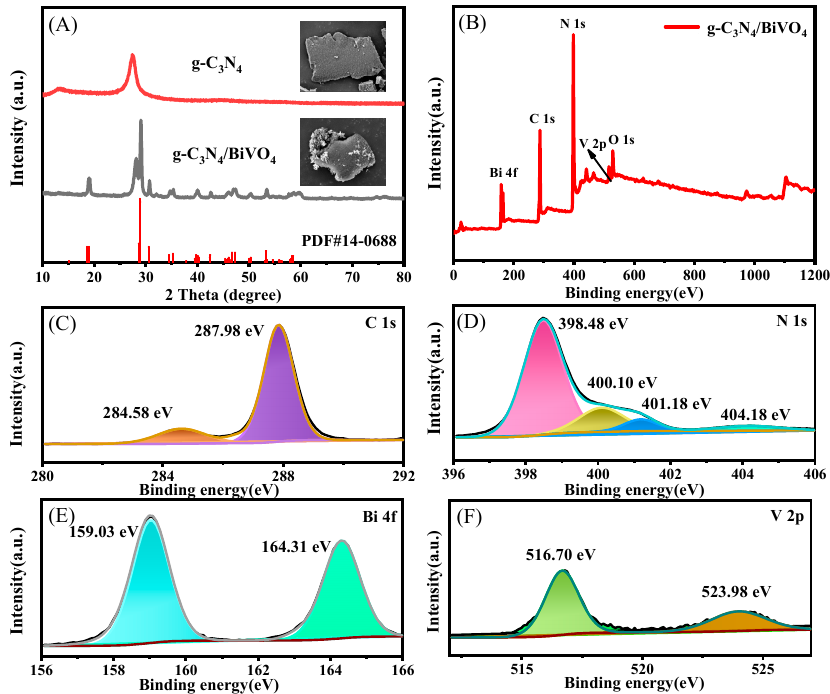
Figure 1. ( A ) SEM images and XRD patterns; ( B ) XPS survey spectrum; ( C – F ) corresponding high-resolution XPS spectra of the prepared materials.